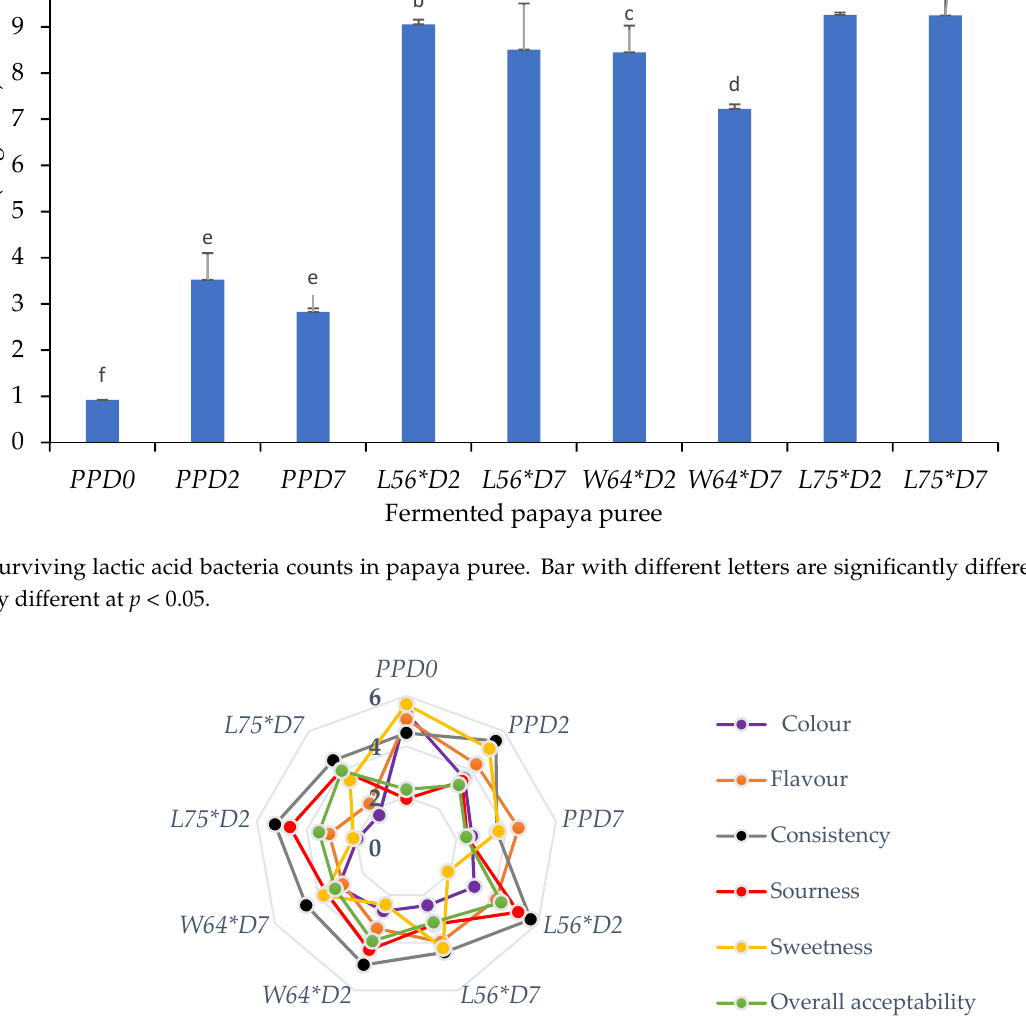
Figure 2. Sensory attributes of pasteurised and fermented papaya puree.